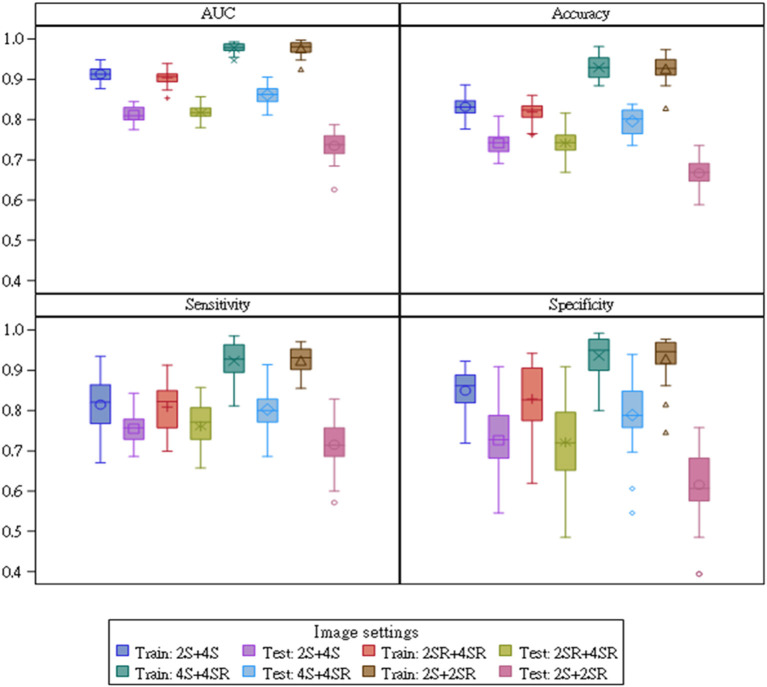
Comparisons of performance index values for 32 runs for four parameter settings. The 4S+4SR setting yielded the largest area under the receiver operating characteristic curve, accuracy, sensitivity, and specificity scores during training and testing. 2S, apical 2-chamber strain map; 2SR, apical 2-chamber strain rate map; 4S, apical 4-chamber strain map; 4SR, apical 4-chamber strain rate map.